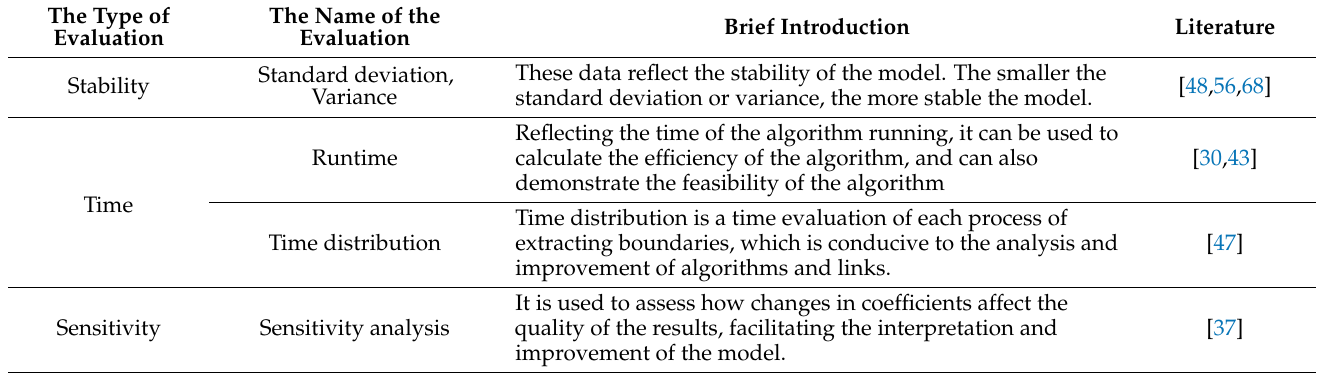
Table 6. Evaluations of related